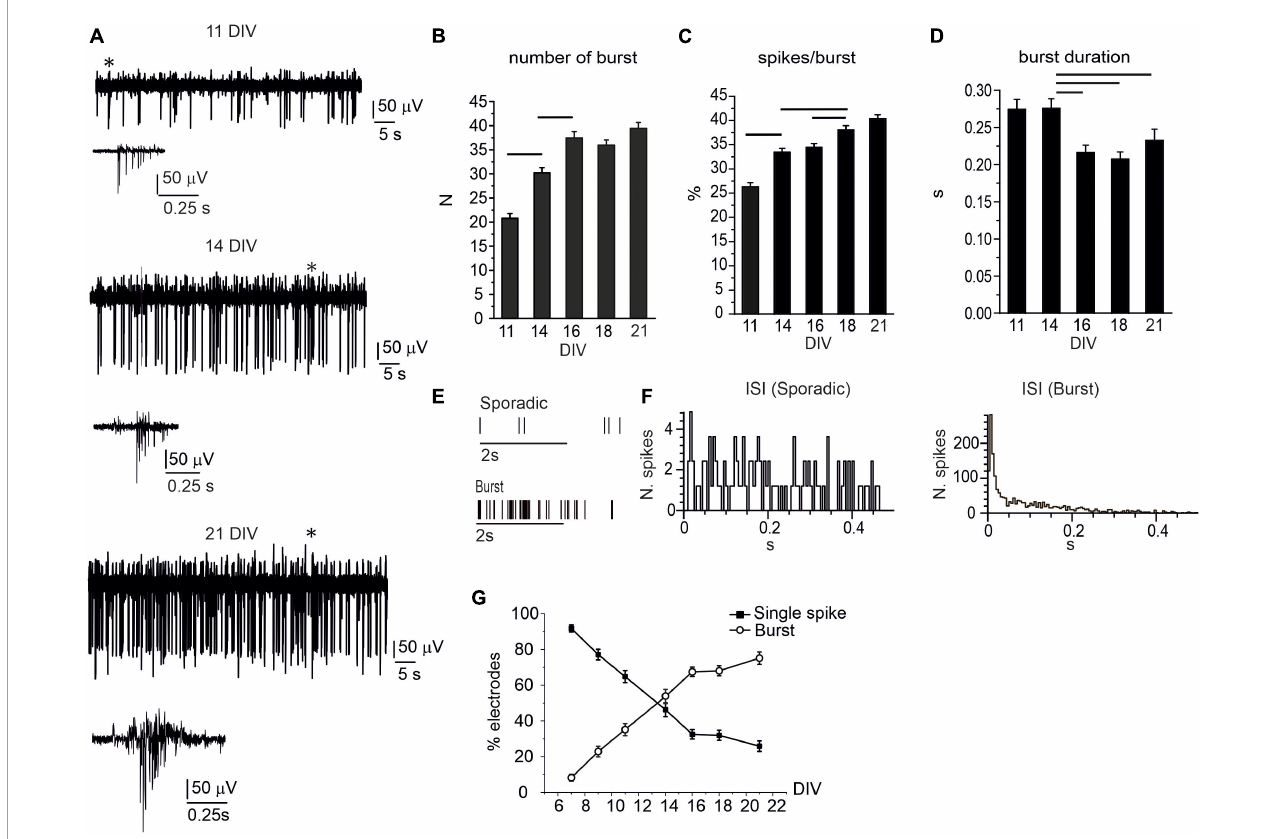
FIGURE2 The burst activity progressively increases during network development. (A) Representative traces detected by the same electrode at 11, 14, and 21 DIV. Bursts (indicated by the asterisks) are shown at higher magnifications below the corresponding traces. (B) Bar plot of the mean number of bursts during 120 s recordings. Significant difference is indicated by the horizontal lines (11 DIV vs. 14 DIV, p < 0.0001; 14 DIV vs. 16 DIV, p < 0.0001). (C) Mean percentage of spikes within bursts, during 120 s recordings (11 DIV vs. 14 DIV, p < 0.0001; 14 DIV vs. 18 DIV, p < 0.0001, 16 DIV vs. 18 DIV, p = 0.01). (D) Mean burst duration in the range 11–21 DIV (14 DIV vs. 16 DIV, p = 0.0049; 14 DIV vs. 18 DIV, p < 0.0001; 14 DIV vs. 21 DIV, p = 0.05). (E) Raster plot for two representative electrodes detecting sporadic firing and burst activity. (F) Inter-spike interval (ISI) distribution shown for two representative microelectrode arrays (MEA) electrodes detecting either sporadic (left) or burst activity (right). (G) Percentage of electrodes detecting either sporadic or burst activity during network